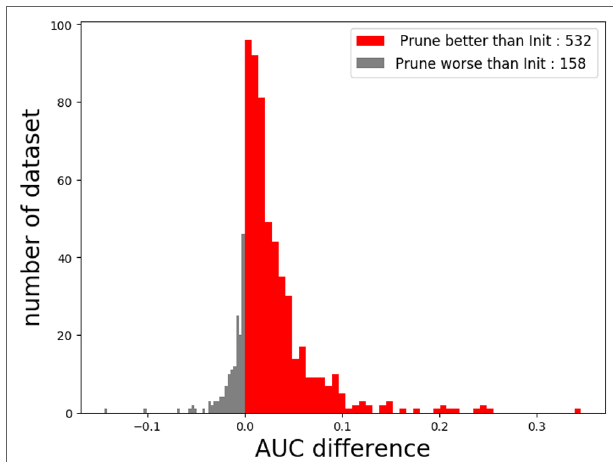
FIGURE 6 | The performance of Deepprune with four kernels on real datasets where kernel length = 15. Deepprune greatly increases the AUC for real datasets. The AUC difference under the baseline (Init) and Deepprune (Prune) is shown from the x axis. Deepprune is better than baseline on 532 datasets, but worse than baseline with 158 datasets. This figure clearly shows that Deepprune achieves better performance with limited kernel